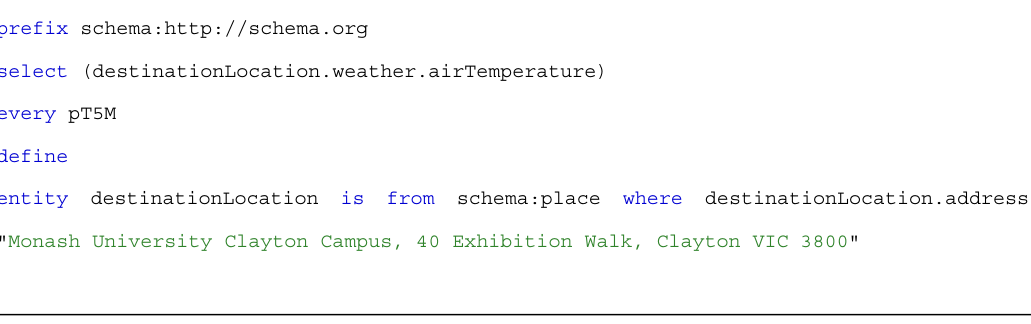
Scheme 6. Example of a basic